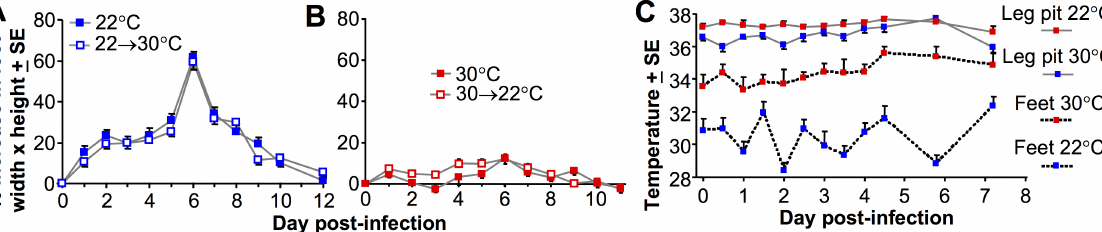
Fig 3. Moving mice from 22˚C to 30˚C and vice versa. (A) Foot swelling in mice infected s.c. in the feet and held at 22˚C (22˚C) or held at 22˚C and then at the end of day 4 post infection moved to 30˚C (22˚C ! 30˚C); (n = 12 feet from 6 mice per group). (B) Foot swelling in mice infected s.c. in the feet and held at 30˚C (30˚C) or held at 30˚C and then at the end of day 4 post infection moved to 22˚C (30˚C ! 22˚C); (n = 12 feet from 6 mice per group). (C) Temperature measurements were taken in the rear leg pits and the surface of feet of mice housed at 22˚C or 30˚C on the indicated days post s.c. infection in the feet (n = 6 mice per group). Measurements were taken using a pediatric infra-red thermometer, and were taken in quadruplicate to produce a mean for each mouse, with the mean of 6 mice and SE